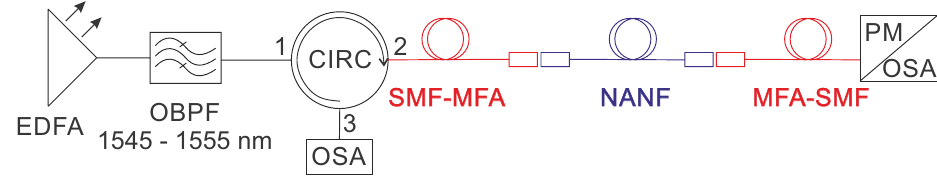
Figure 4. Setup used for insertion loss and back-reflection measurement of SMF-NANF-SMF interconnect for GRIN/TEC MFA